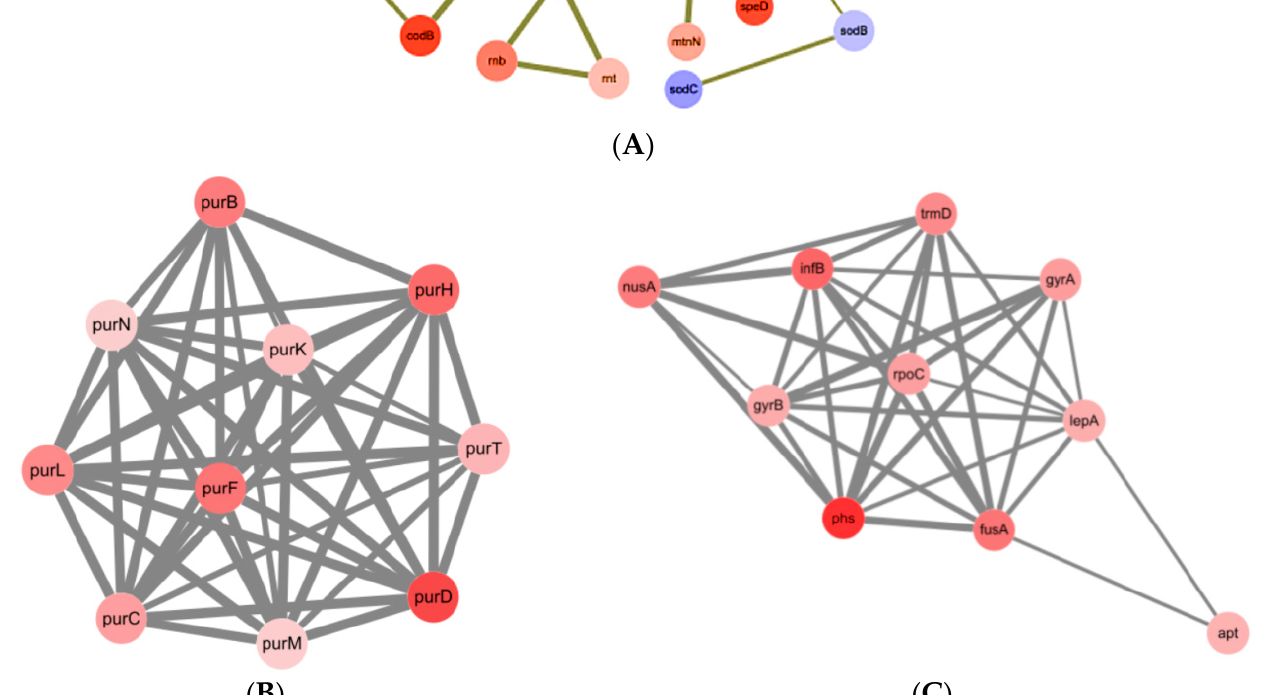
Figure 4. Network analysis of co-DEGs selected for underlying resistance mechanism. ( A ) Using the STRING online database, total of 120 co-DEGs were filtered into the PPI network and visualized by Cytoscape; ( B , C ) top two PPI networks in MCODE analysis.